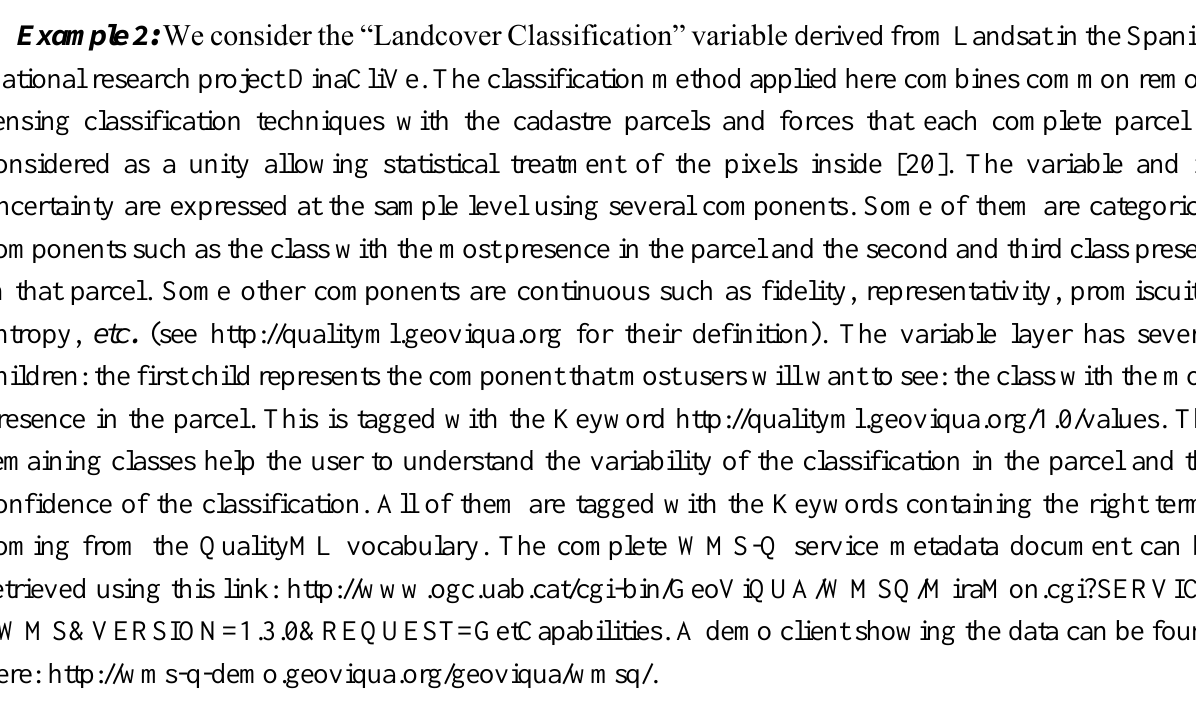
Figure 2. Schematic representation of the structure of Layers in a particular “quality-enabled” profile of Web Map Service (WMS-Q) service instance, illustrating the Service-Dataset-Variable-Component hierarchy. Each box is a Layer in the tree: blue boxes represent non-displayable Layers, whereas orange boxes represent displayable Layers. The derivation of this hierarchy is given in Section